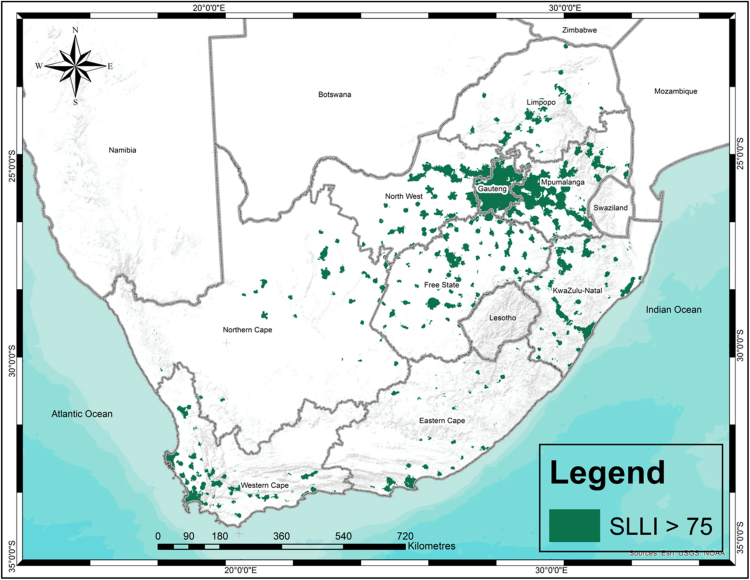
Highly strategic land or land with a strategically located land of over 75.